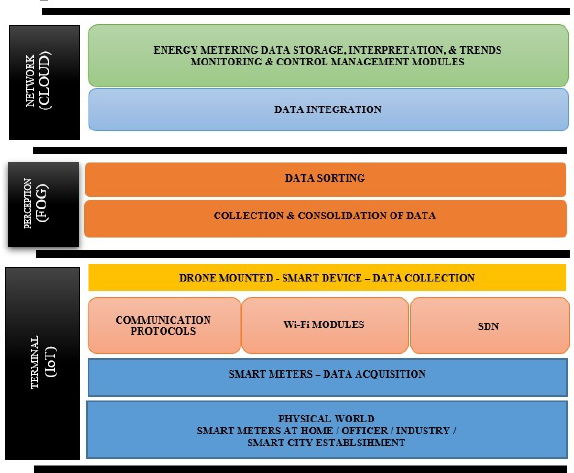
Fig. 3. IoT-Fog-Cloud layer architect (Source: Author’s own elaboration).